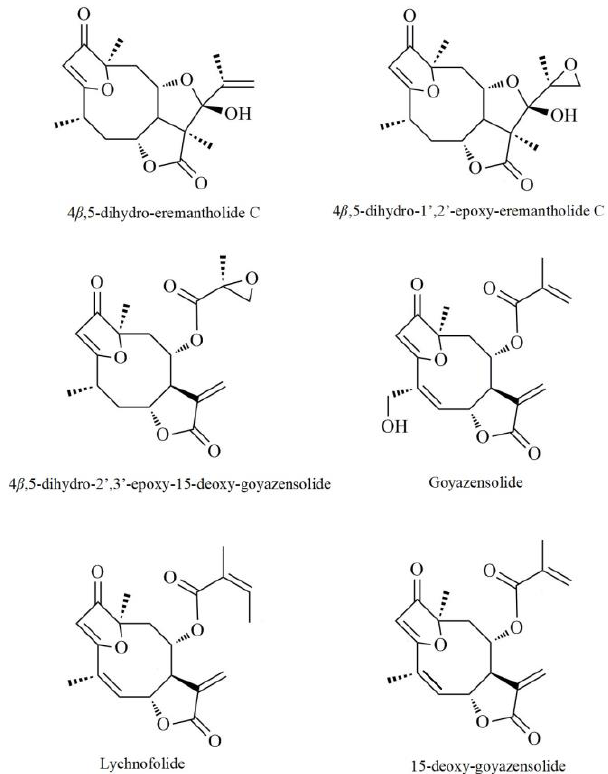
Figure 8. Chemical structures of sesquiterpene lactones screened in the present study, adapted from references [4] and [5].